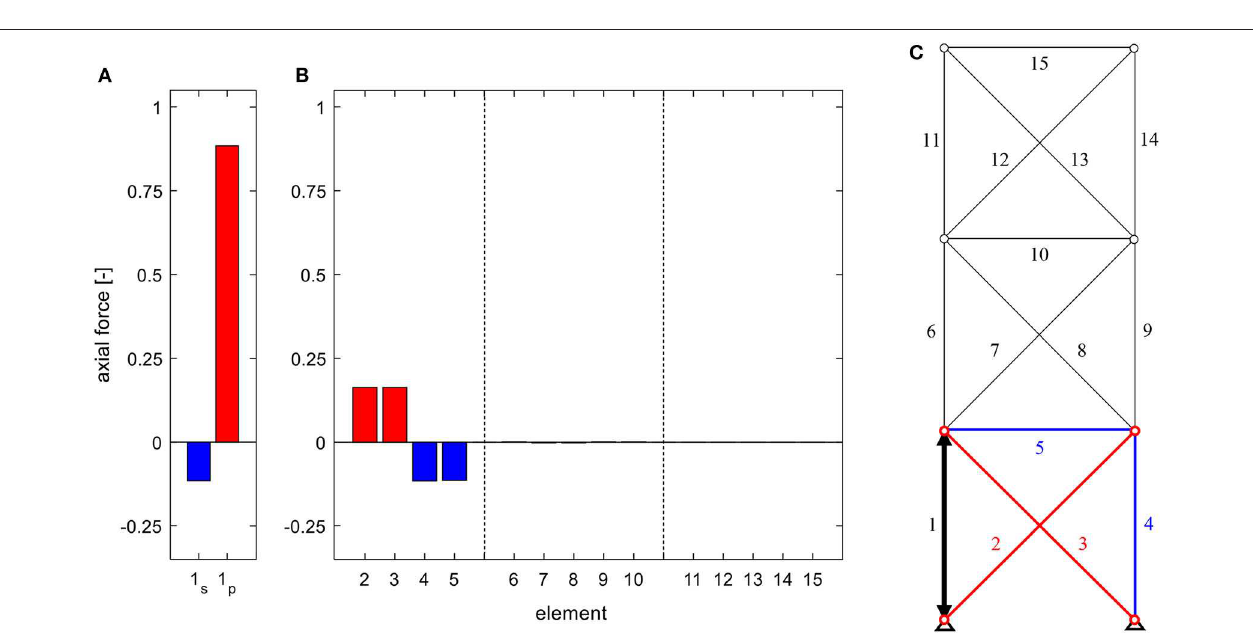
FIGURE 10 | Axial forces in (A) the actuated element for serial (index s ) and parallel (index p ) linear actuation, (B) the remaining structure due to the actuation of element 1 (C) , for a truss of the static degree of indeterminacy of n s = 3 and with modules of increased stiffness bottom to top.